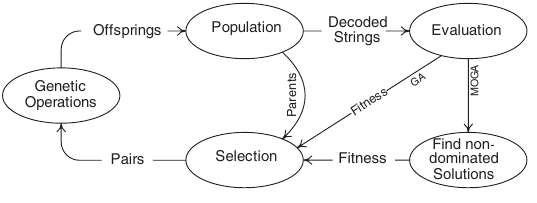
Fig. 5. GA and MOGA reproduction